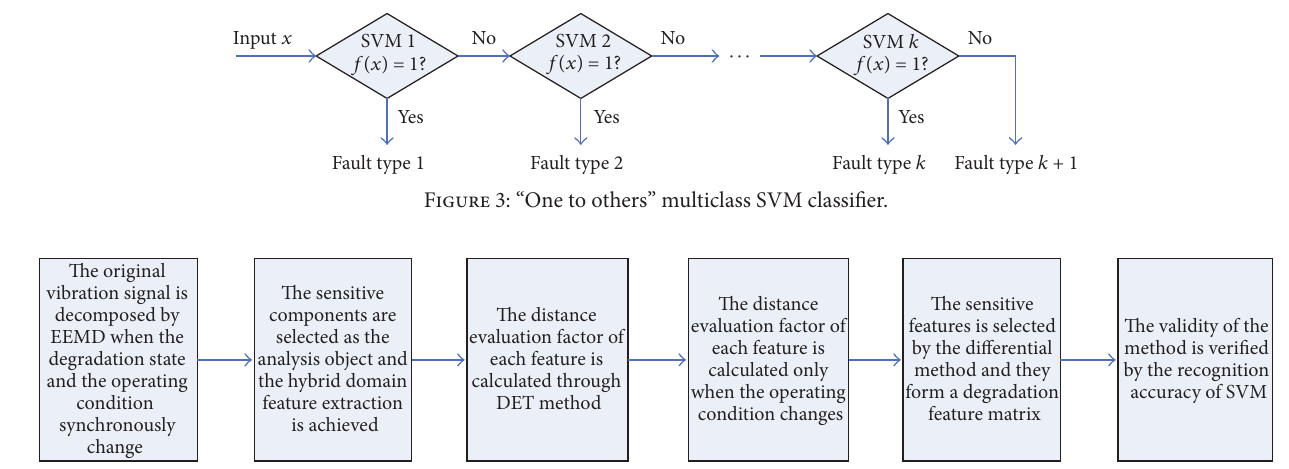
Figure 4: Motor bearing degradation feature extraction process based on